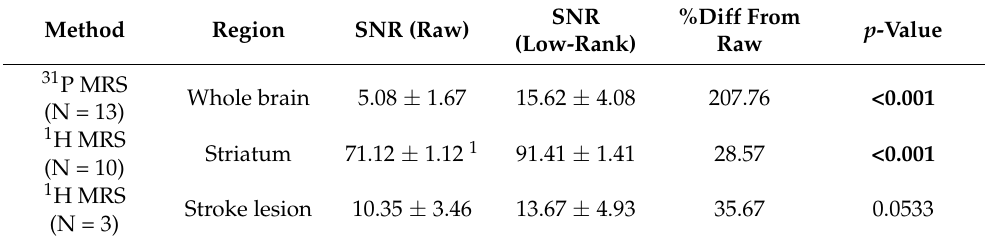
Table 1. SNR differences between raw and denoised data.